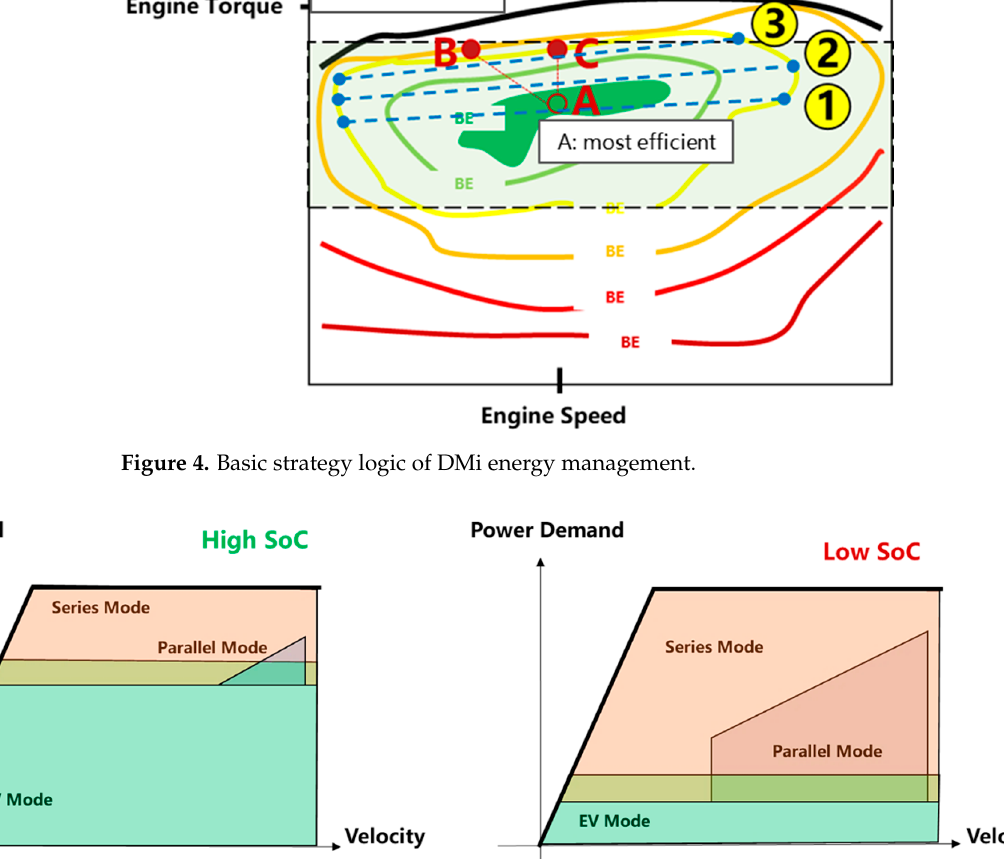
Figure 5. Basic strategy logic of DMi mode selection.